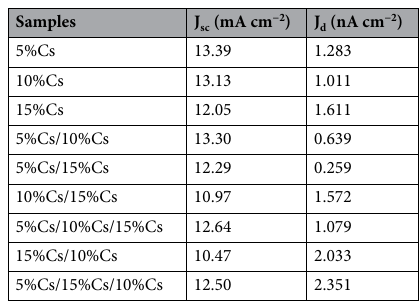
Table 2. Average short circuit current density and dark current density of single, double, and triple-layer PPDs over 4 devices.